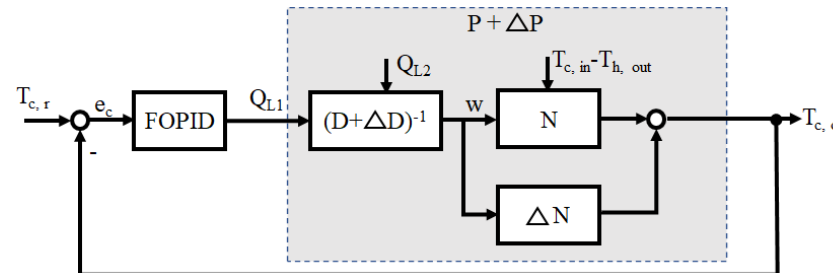
Figure 8. Fractional order robust control with FOPID.